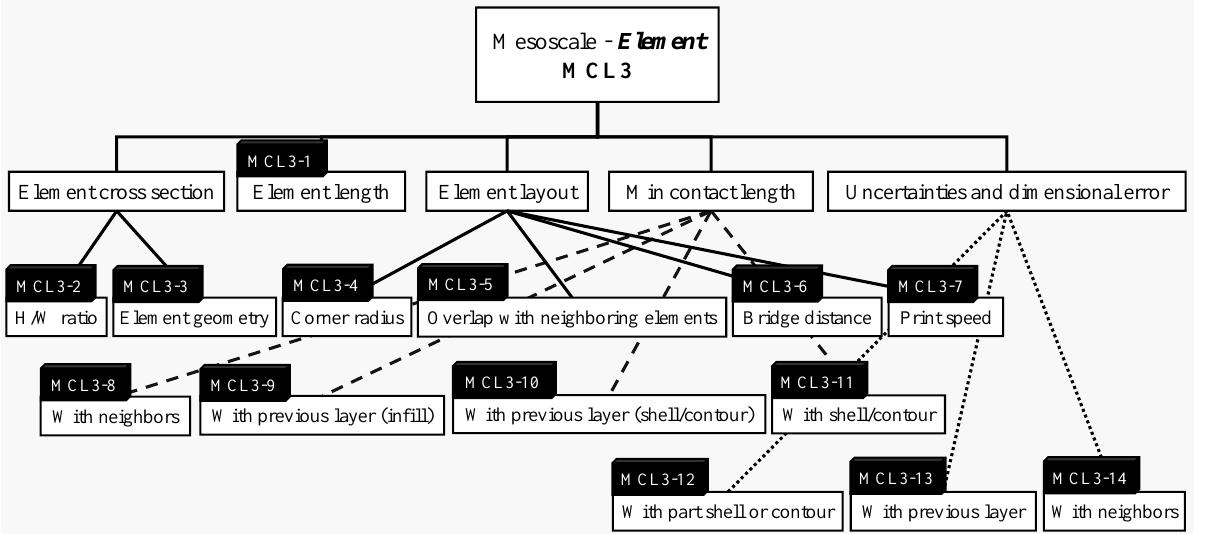
Figure 9. Essential manufacturing constraints at the single-element mesoscale